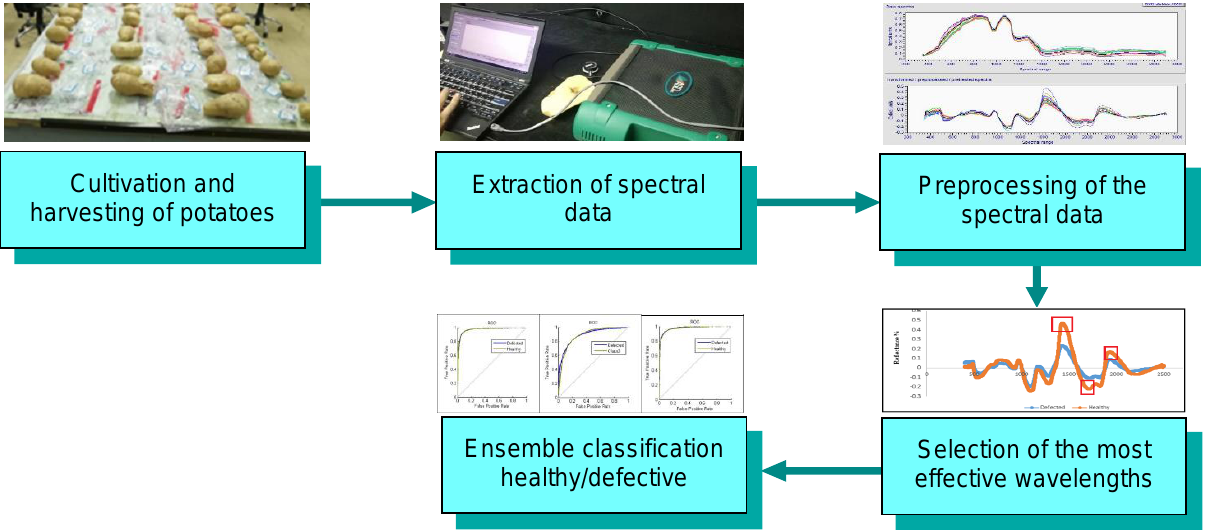
Figure 1. Stages of the applied methodology for detecting deficiencies in potatoes using Vis/NIR spectroscopy.